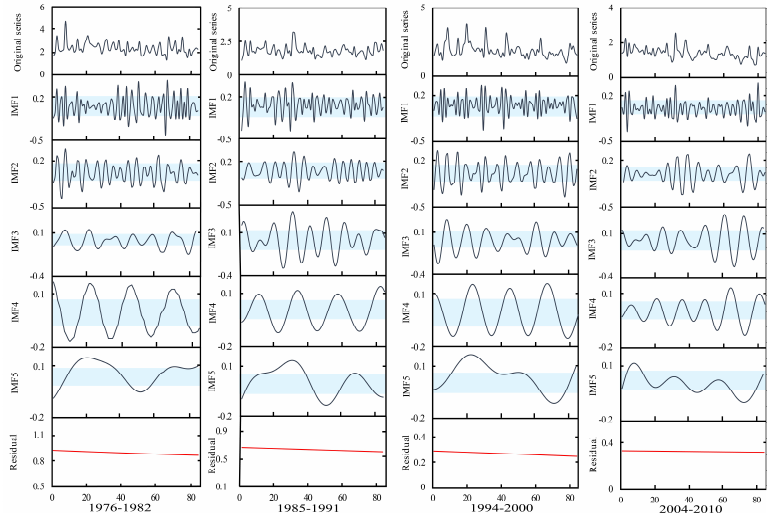
Figure 9. Segmented decomposed series of measured monthly runoff at Gaojiabao gauge.